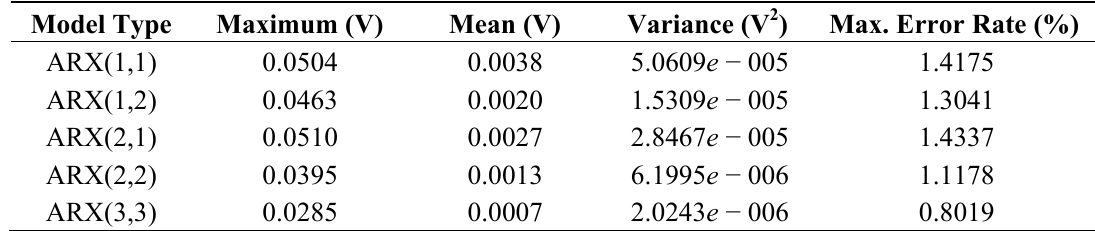
Table 4. The statistic analysis list of the absolute values of terminal voltage errors.